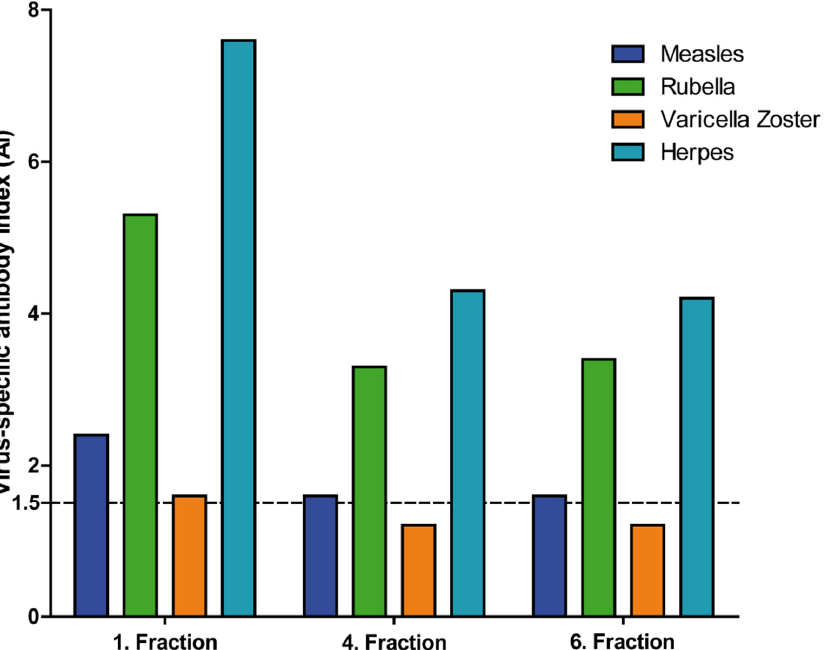
Figure 2. Virus-specific antibody indices (AI) in a patient suffering from multiple sclerosis and normal pressure hydrocephalus (NPH). Depicted are the virus-specific AI in three different cerebrospinal fluid (CSF) fractions in a measle-, rubella-, varicella zoster virus (MRZ)-positive patient suffering from secondary progressive multiple sclerosis (SPMS) and NPH. The first CSF fraction consisted of the first 5 mL obtained at the lumbar puncture, the fourth fraction of the 15–20 mL and the sixth fraction of the 25–30 mL. Shown are the AIs for measle virus, rubella virus, varicella zoster virus and herpes simplex virus. The dashed line at 1.5 represents the cutoff for positive virus-specific AI.